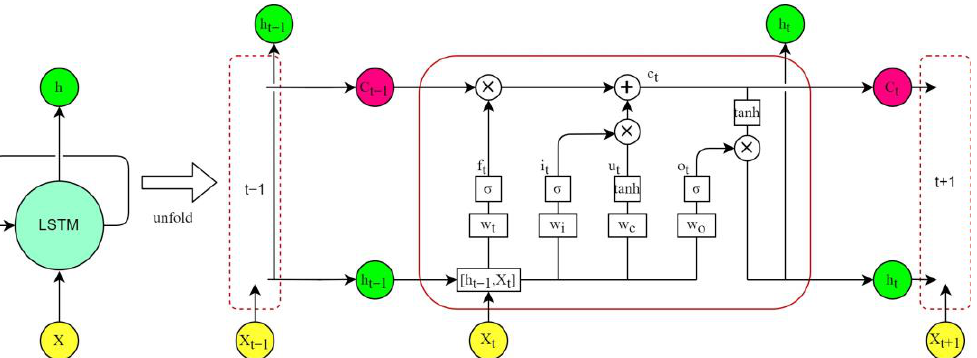
Figure 4. Structure of the unfolded LSTM cell. In the figure, ⊗ represents the Hadamard product, which is the multiplication of the corresponding elements of the matrix, ⊕ represents the sum of the corresponding elements of the matrix. W and b represent the weight matrix and bias matrix corresponding to the control gate, σ represents sigmoid activation, and tanh represents hyperbolic tangent activation.